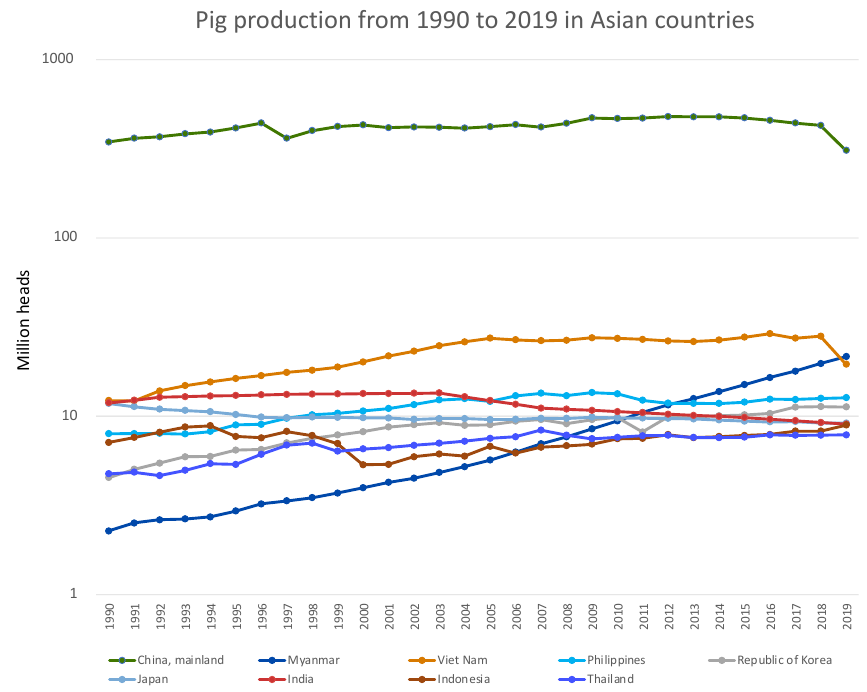
Figure 2. Trends in pig production from 1990 through 2019 for the nine Asian countries in Figure 1. Combined with robust hygiene practices, vaccination is one of the most effective control measures to reduce SI-associated economic loss at the farm level [4]. However, due to the error-prone nature of the viral RNA polymerase [17], non-synonymous